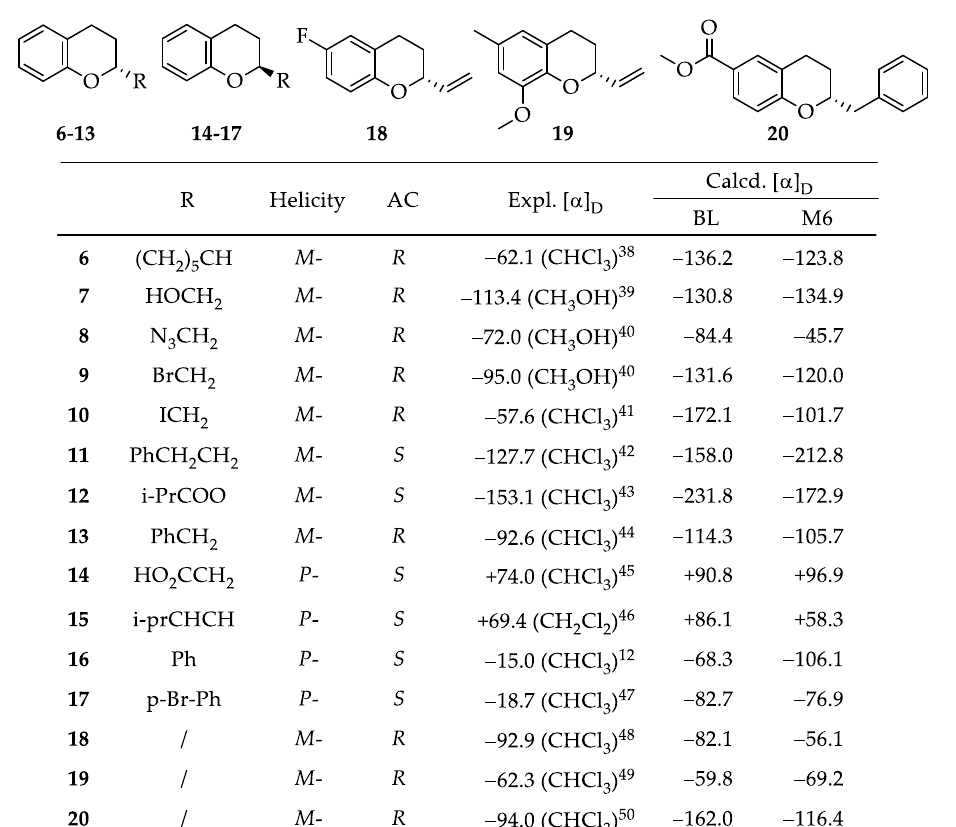
Figure 3. Experimental and calculated SORs for typical 2-substituted chromanes. BL: PCM/B3LYP/Aug-cc-pVDZ//B3LYP/6-311G(d,p), M6: PCM/M06-2X/Aug-cc-pVDZ//M06-2X/TZVP. Experimental SOR data were collected from references [12,38 –